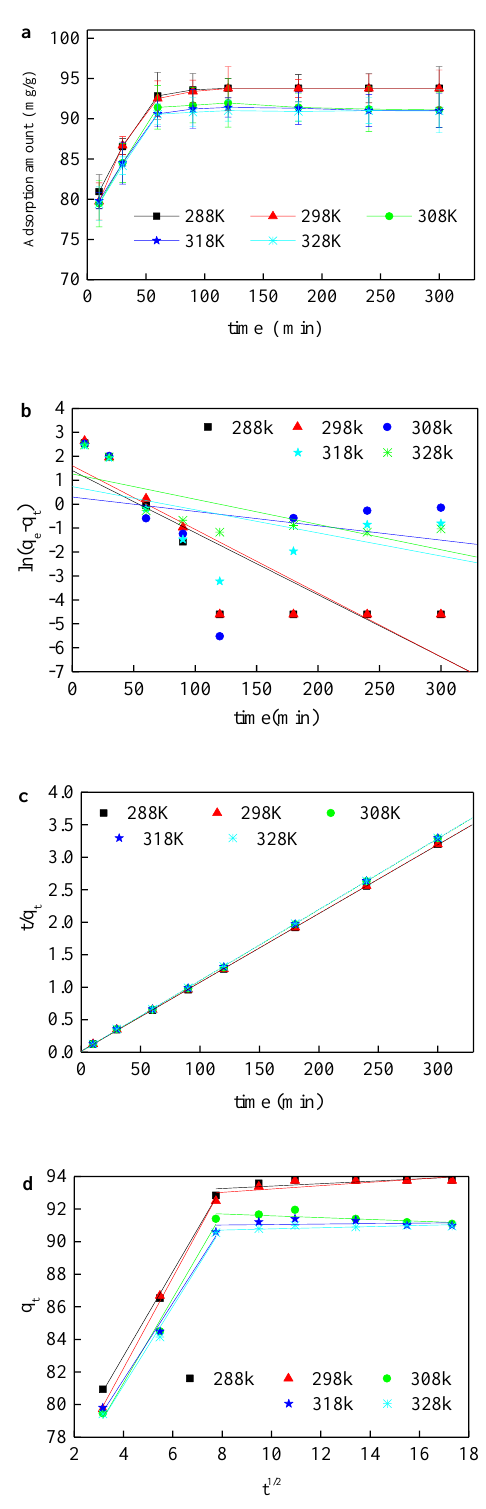
Figure 5. ( a ) Effect of adsorption duration on the adsorption amount at various temperatures; ( b ) fitting of experimental data with the quasi-first-order reaction kinetics model at various temperatures; ( c ) fitting of experimental data with the quasi-second-order reaction kinetics model at various temperatures; ( d ) fitting of experimental data with the intraparticle diffusion model at various temperatures. The adsorption test was conducted with 200 mg / L Acid Orange II and 2 g / L modified sepiolite under an oscillation rate of 180 r / min and an initial pH value of